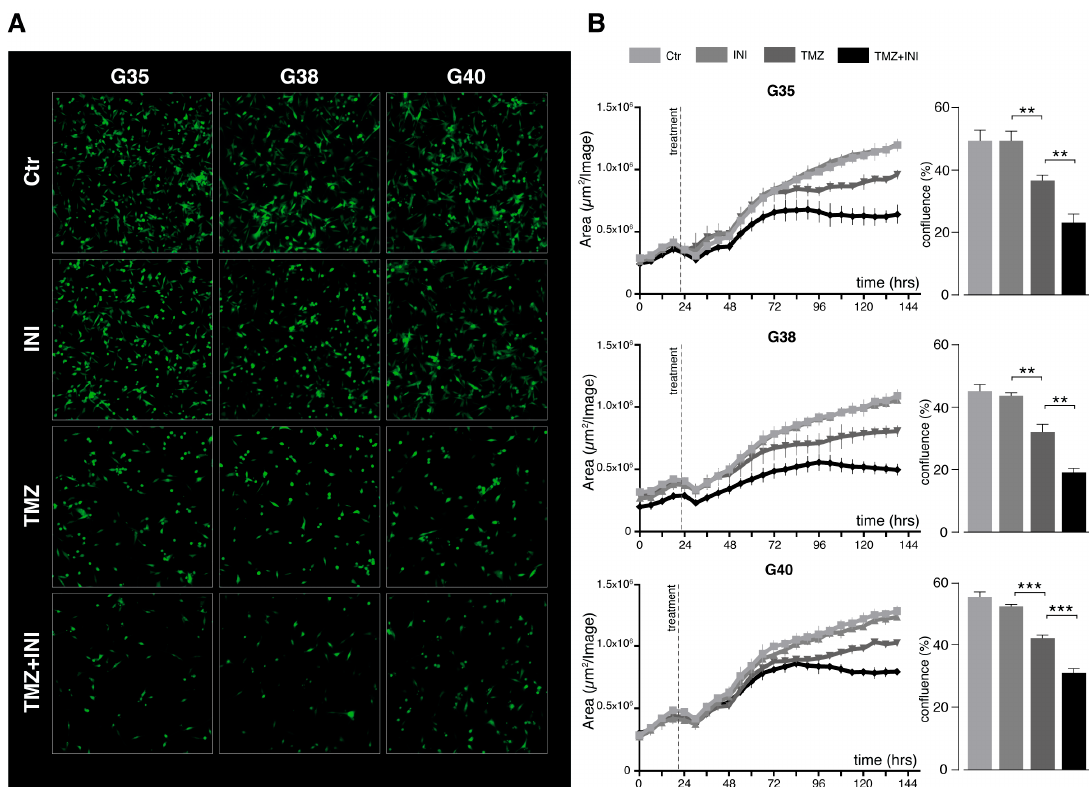
Figure 3. Gap junction-targeted therapy diminishes glioblastoma cell confluence. ( A ) Fluorescence images: cells were treated with 50 µM TMZ, 100 µM INI, combination of both, or left untreated. Images were taken after 6 days. One representative image out of three is shown for each cell population and treatment modality. Magnification: 10×. ( B ) Analysis of cellular confluence: quantification of fluorescence images taken with The IncuCyte ® S3 Live-Cell Analysis System. Cells were treated with 50 µM TMZ, 100 µM INI, combination of both, or left untreated. Cell confluence was calculated as µm 2 /Image and is depicted in 6 h intervals over a period of 6 days. Barplots to the right represent confluence in percent after 6 days for the different treatment modalities. Mean ± SD of three measurements is depicted. ** and *** denote p < 0.01 and p < 0.001. Ctr, control; G, glioblastoma; and TMZ, temozolomide.